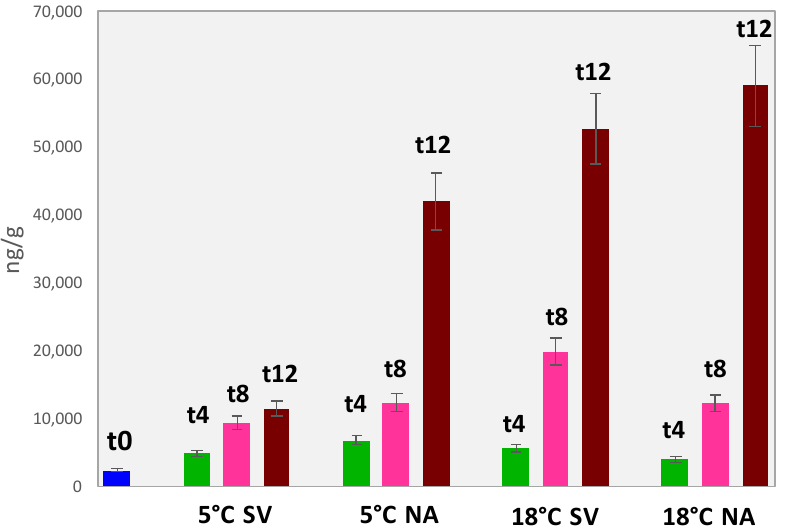
Figure 6. Histogram reporting hexanal equivalents (ng/g) for almond samples analyzed at the different shelf-life time points and storage conditions.